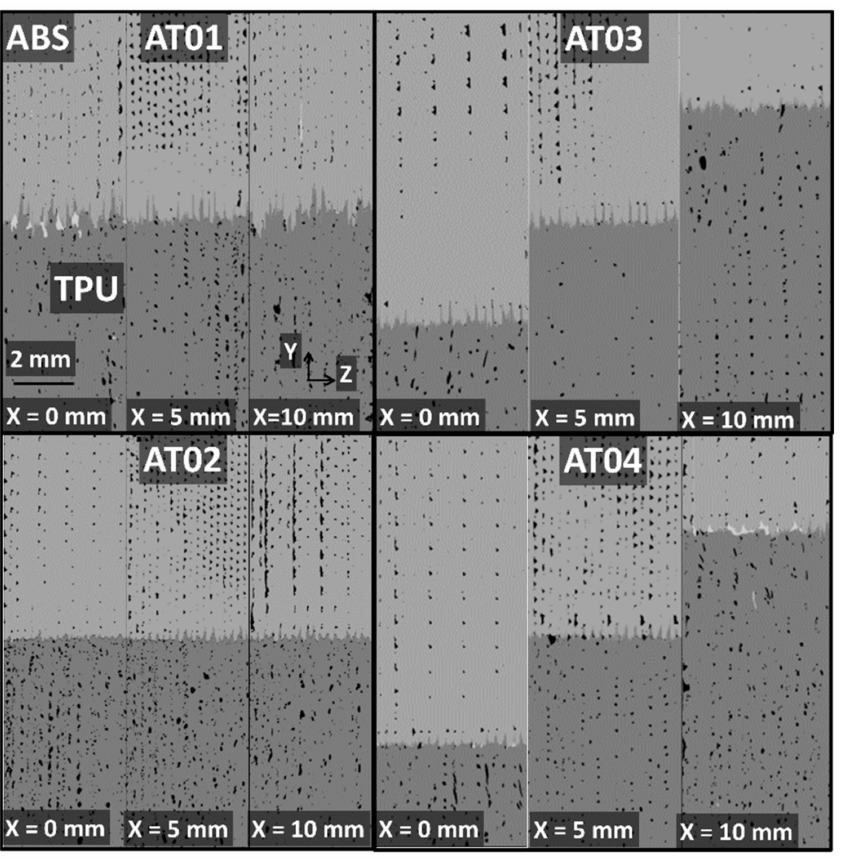
Figure 8. Y–Z cross-section views (dimensions 10 mm × 4 mm) at different width positions (X) for all printed ABS/TPU samples. (The phase contrast was achieved after image